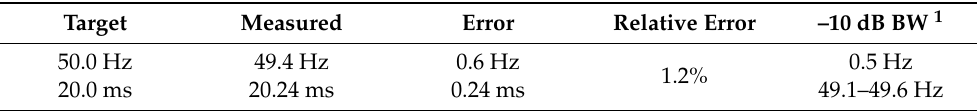
Table 3. Temporal stability of the Testbed’s internal clock.